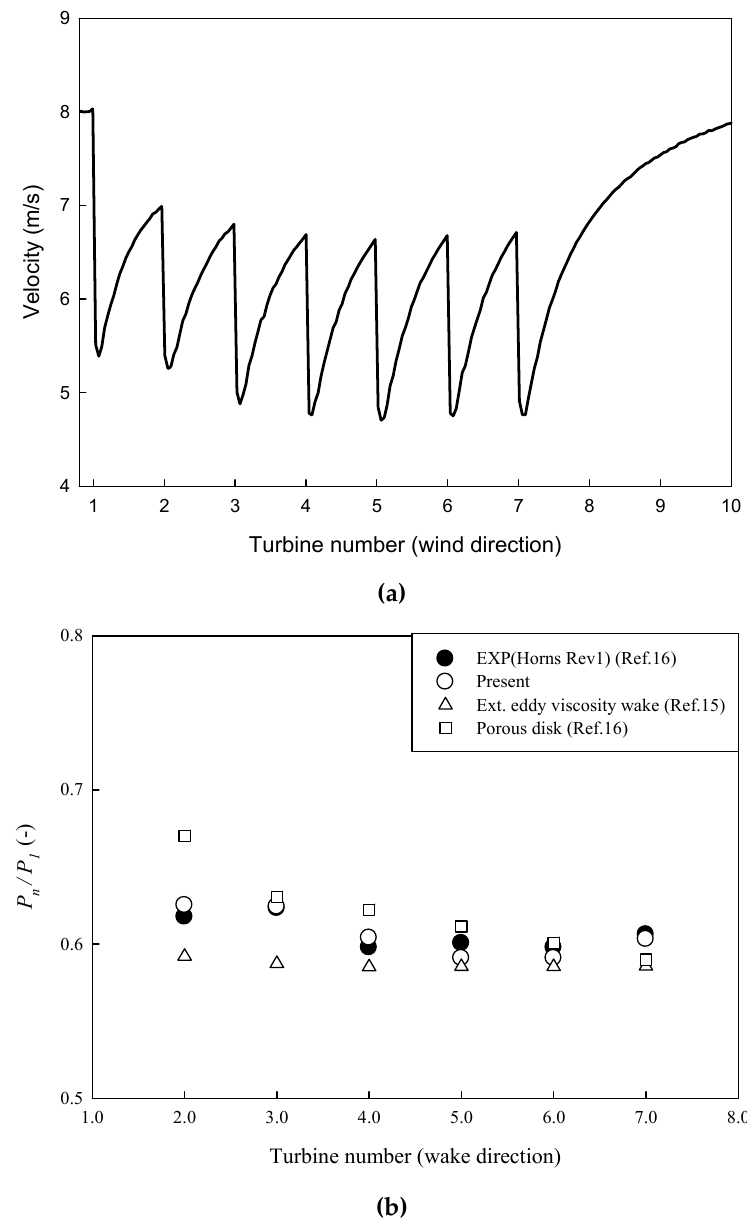
Figure 7. ( a ) The velocity along wake direction; ( b ) Horns Rev1 measurement and the CFD result.